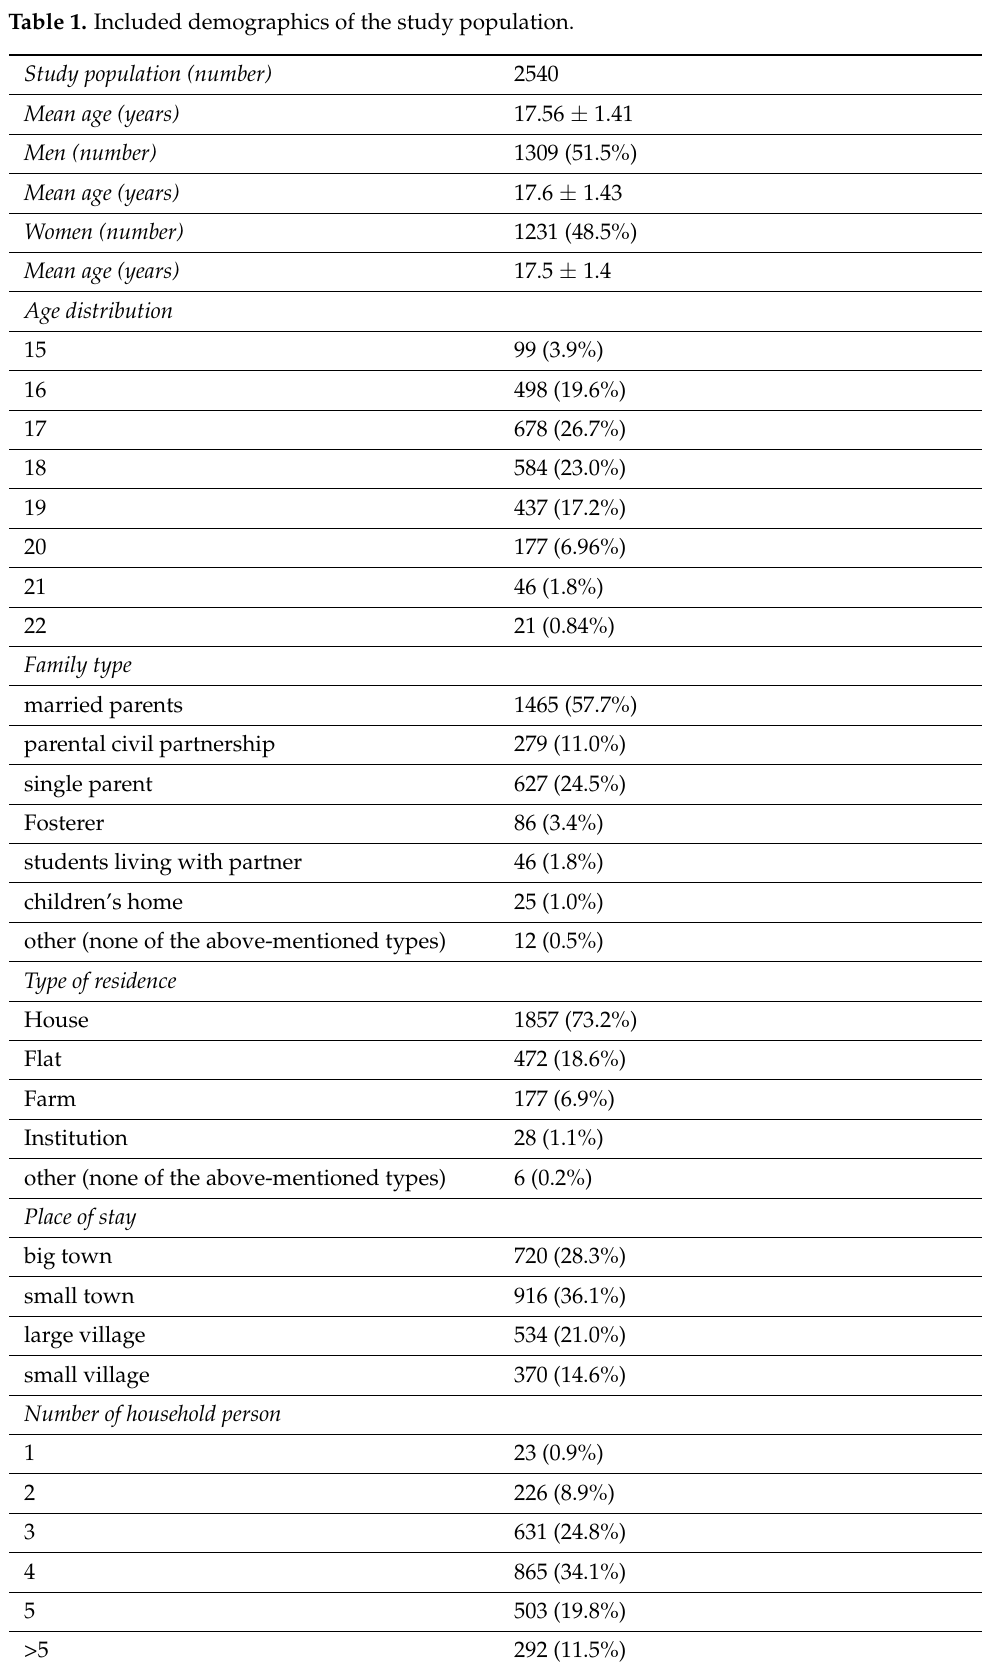
Table 1. Included demographics of the study